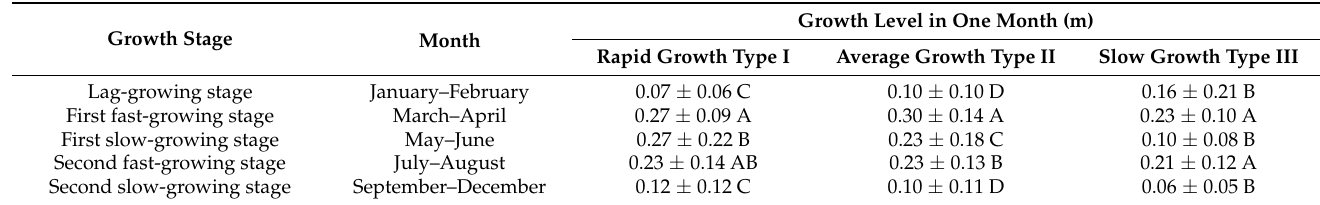
Table 8. Growth stage divisions of crown width between rows for three types of C. axillaris families.